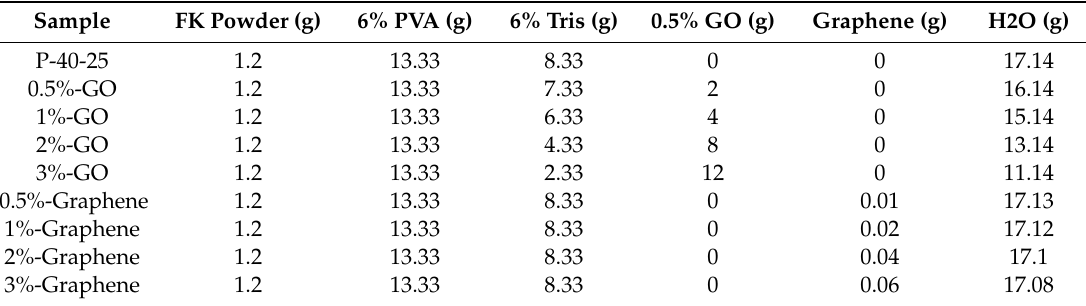
Table 1. Amount of each component in the blend